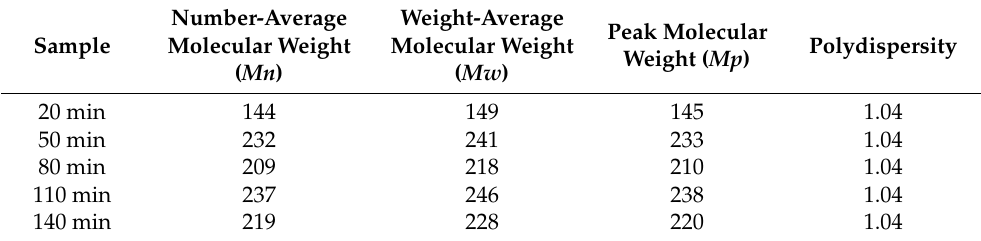
Table 2. The relative molecular weights of the liquefied products at different liquefaction